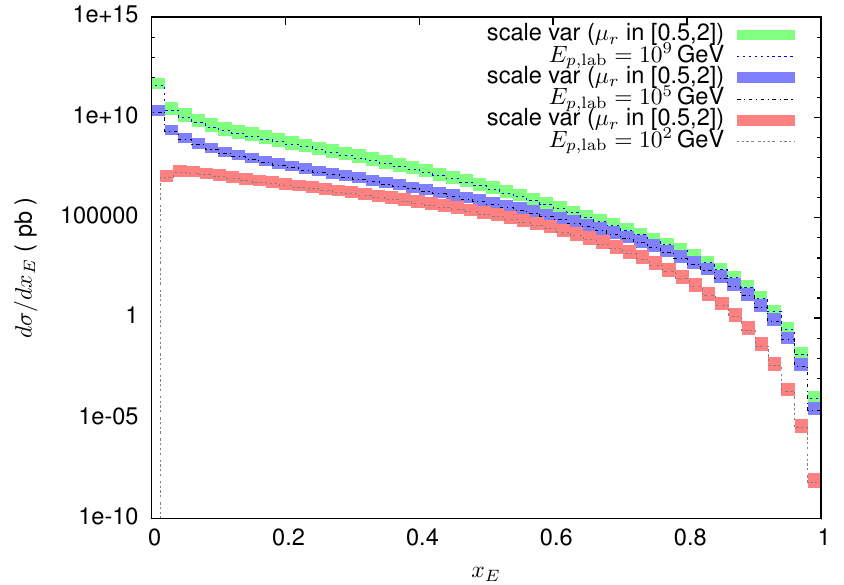
0 hadroproduction, pp D 0 + X , for E for inclusive D ! p 2 + 4 m 2 and (cid:22) i = (cid:22) f = (cid:24)(cid:22) r c T p